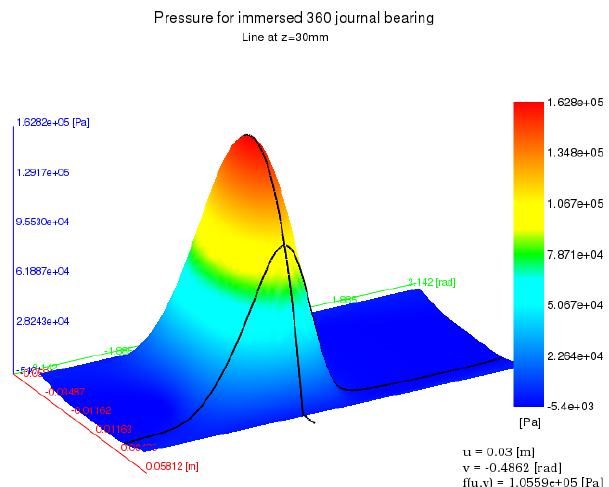
Figure 8: Pressure distribution after transient simula- tion of 3 revolutions, for dispersed air cavi- tation model, with Dowson-Higginson (DH) pure oil compressibility combined with gas compressibility (10% at p = 0), and elastic surfaces. Markers outline the location z = 30 mm.